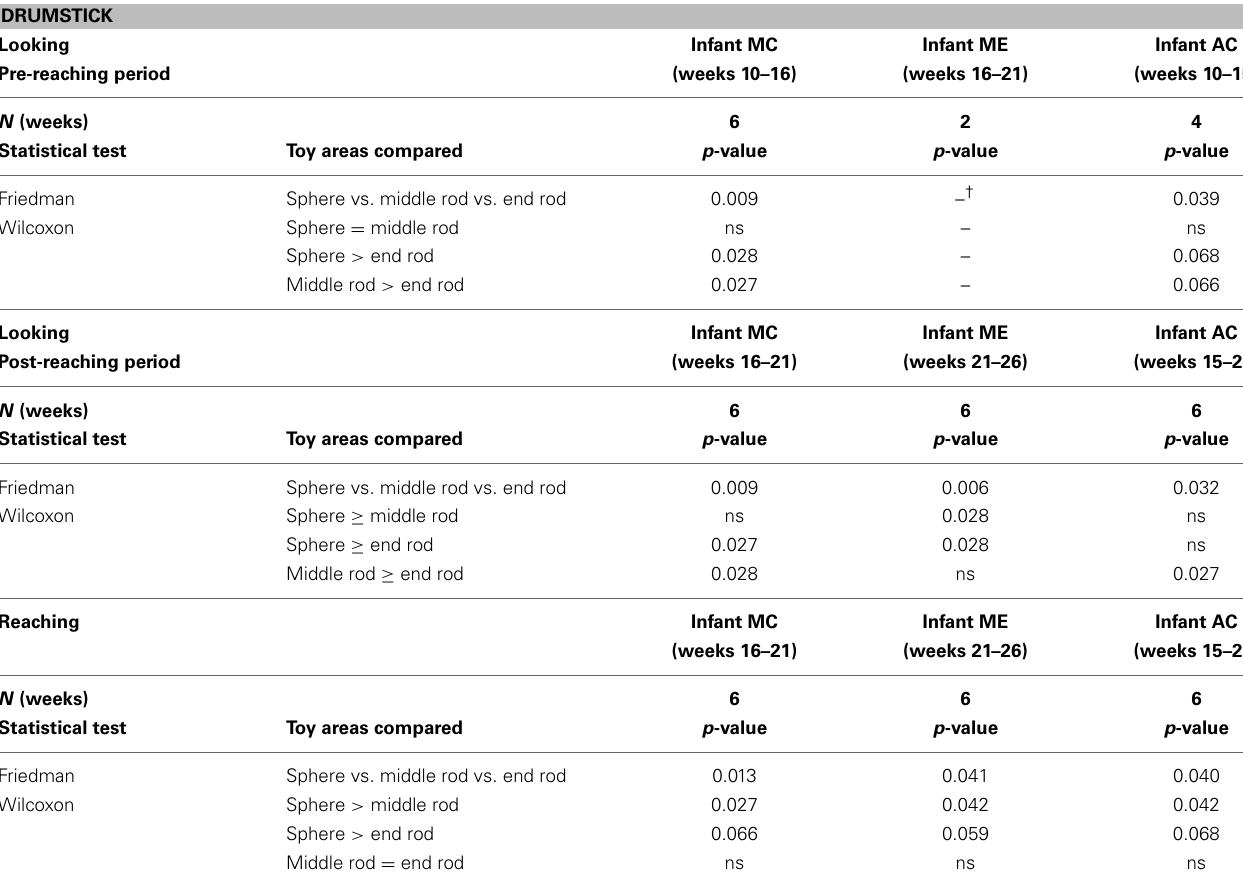
Table 2 | P -values obtained from the statistical tests applied to (1) the individual distributions of accumulated looking directed to each of the three areas of the drumstick (sphere, middle rod, end rod) for the pre- and post-reaching periods, and, (2) P -value of the statistics applied to the individual distributions of the first hand/object